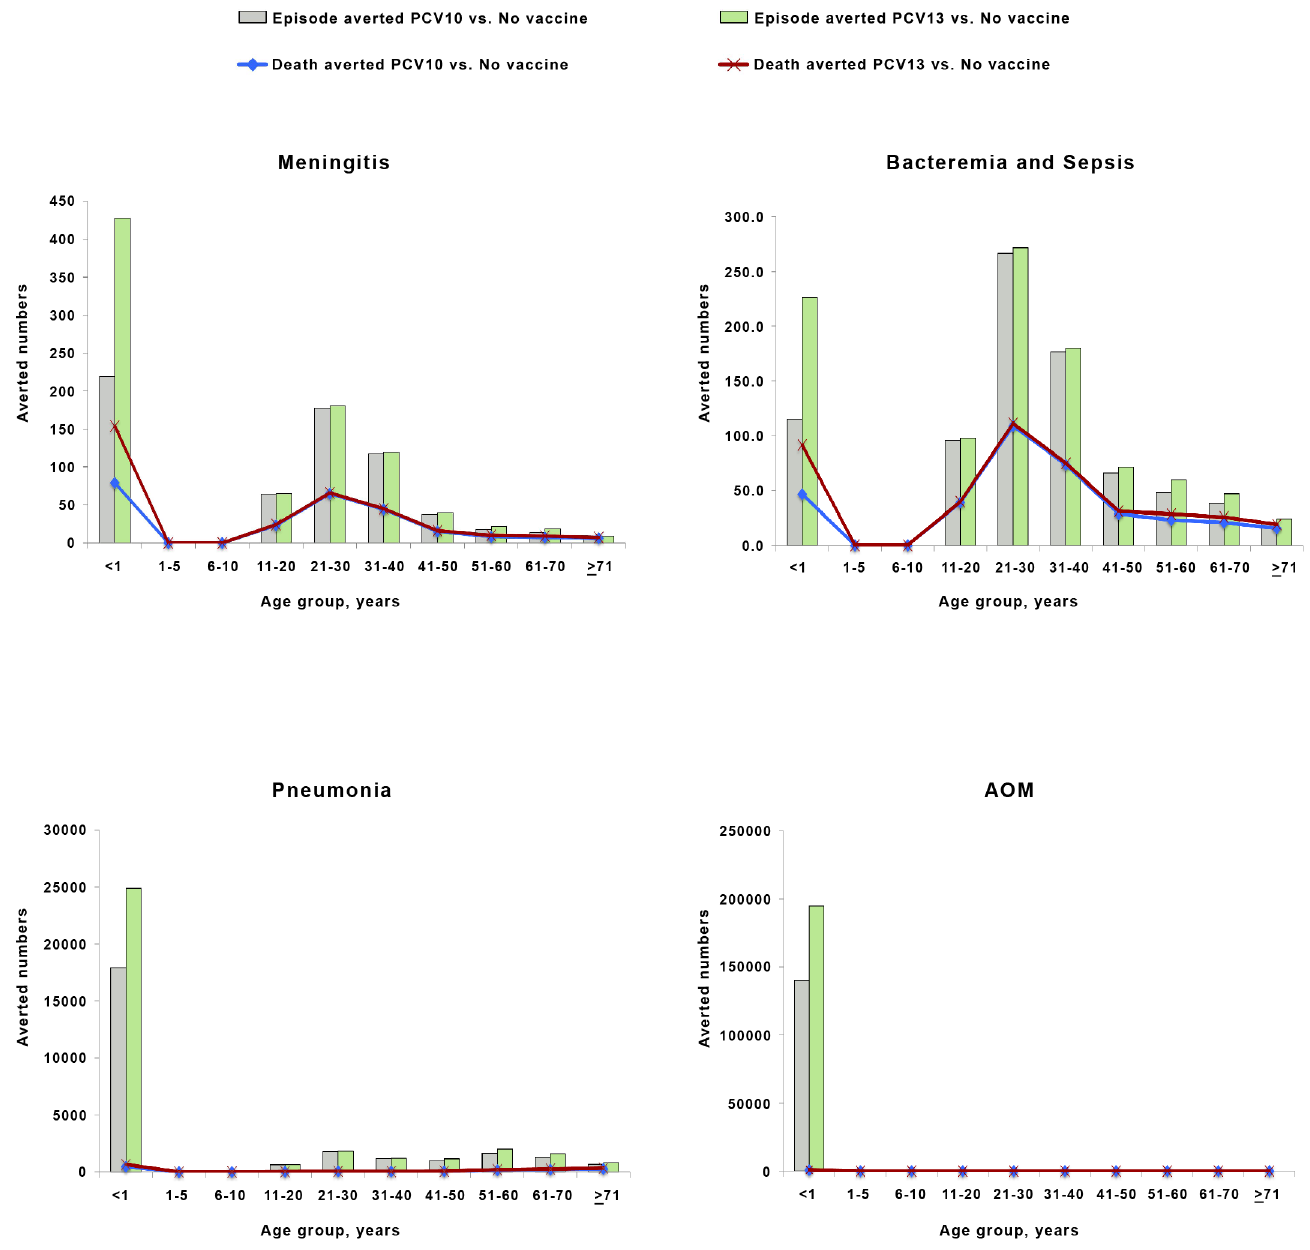
Fig 3. Predicted numbers of life-time pneumococcal disease cases and deaths averted due to vaccination with PCV10 and PCV13 by clinical syndrome and age at entry to the cohort.